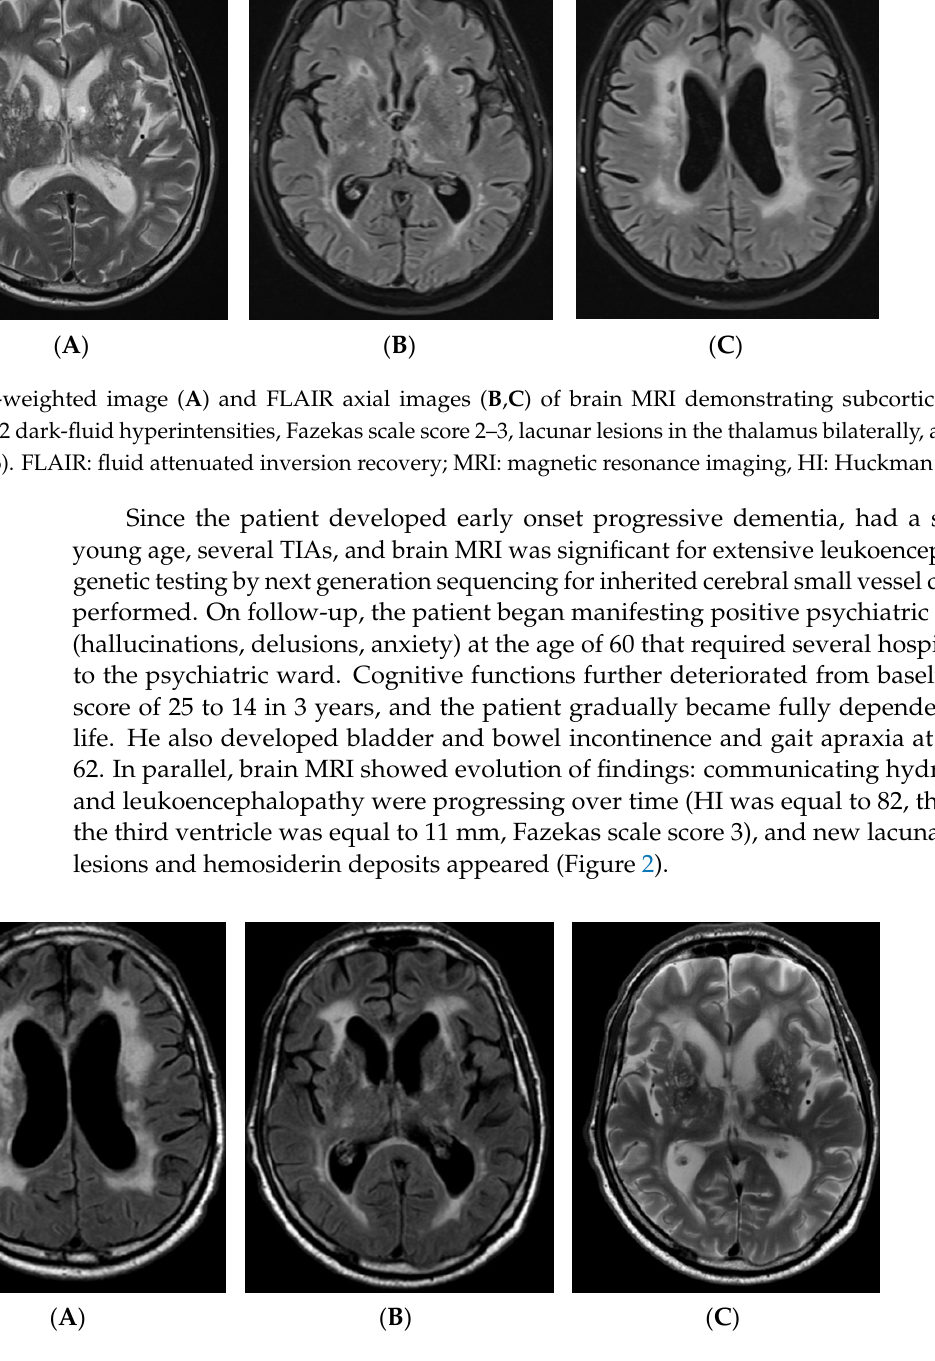
Figure 2. FLAIR axial images ( A , B ) and axial T2-weighted image ( C ) of brain MRI, performed after 3 years of initial brain MRI, demonstrating more subcortical and periventricular T2/T2 dark-fluid hyperintensities, Fazekas scale score 3, new lacunar lesions in right thalamus, progressive ventricu- lar dilation (HI—82). FLAIR: fluid attenuated inversion recovery; MRI: magnetic resonance imag- ing; HI: Huckman index.